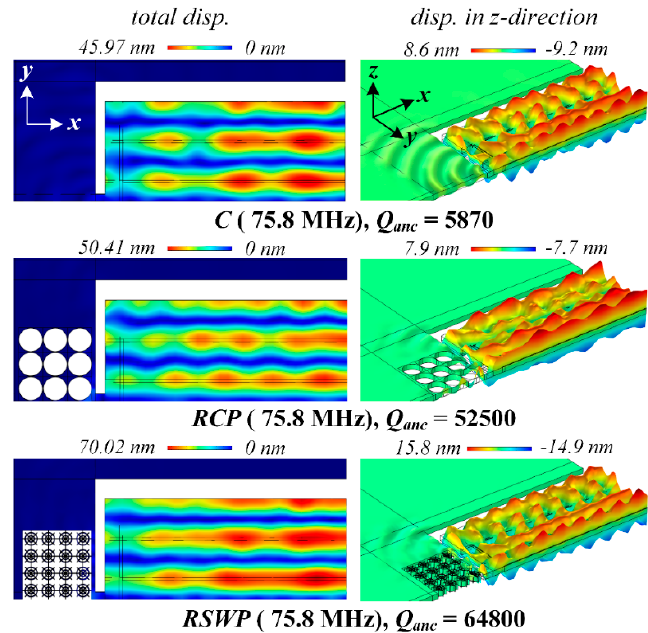
Figure 8. Illustration of displacement distributions of the fifth-order width-extensional resonant mode of the conventional resonator (C), resonator with C-PnC array plates (RCP), and resonator with SW-PnC array plates (RSWP). It is noteworthy that the left side and right side are total displacement and displacement in the z -direction distributions, respectively. The simulated anchor loss ( Q anc ) of resonators agrees well with the transmission property of the delay line and solid line.